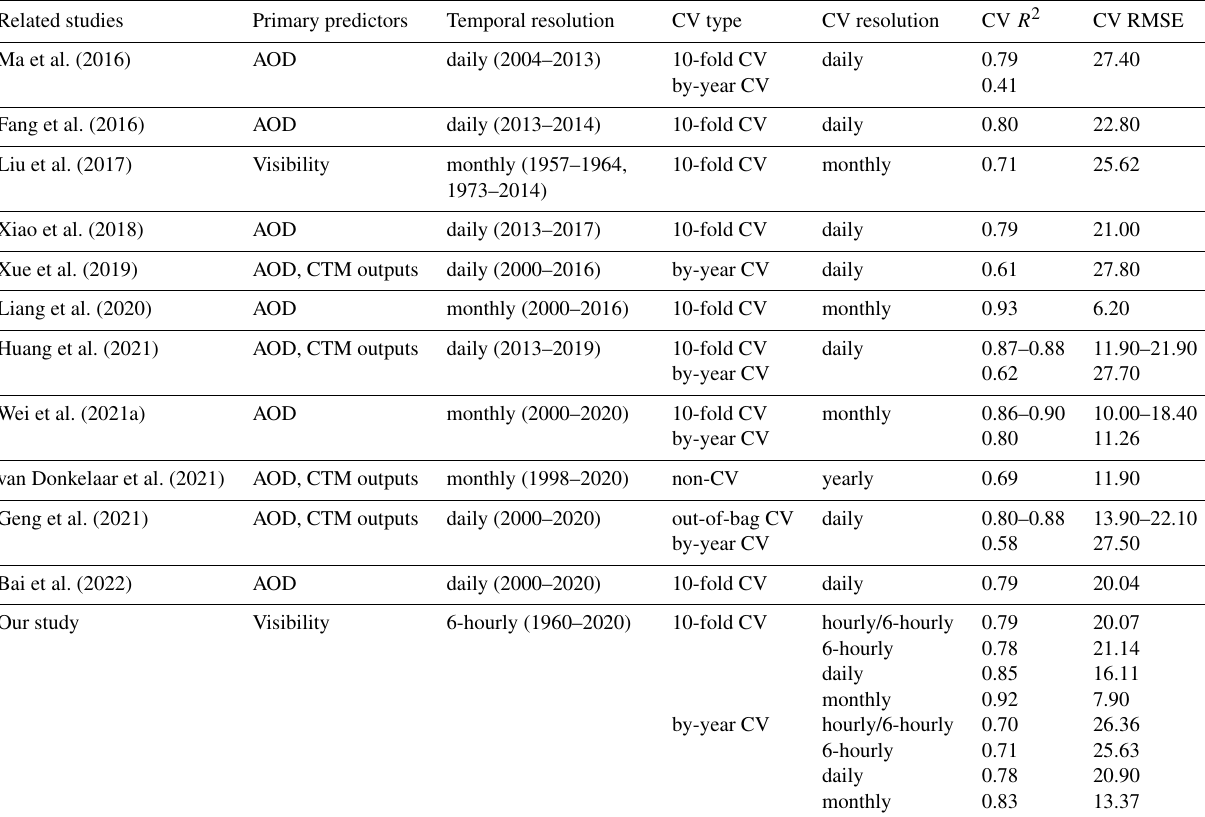
Table 1. Model performance in primary predictors, temporal resolution, and hindcast capability compared with other national PM 2 . 5 datasets in